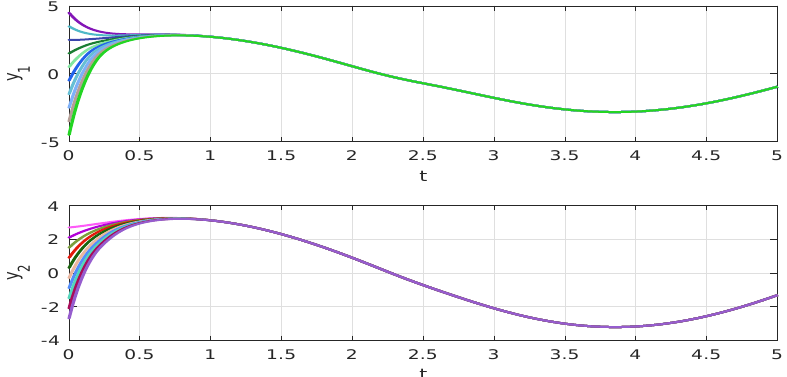
Figure 2. An illustration of the time responses with respect to the imaginary parts pertaining to the model in (20), in which ˜ u ( t ) = sin ( 0.02 t ) e − 0.005 t in Example 1.